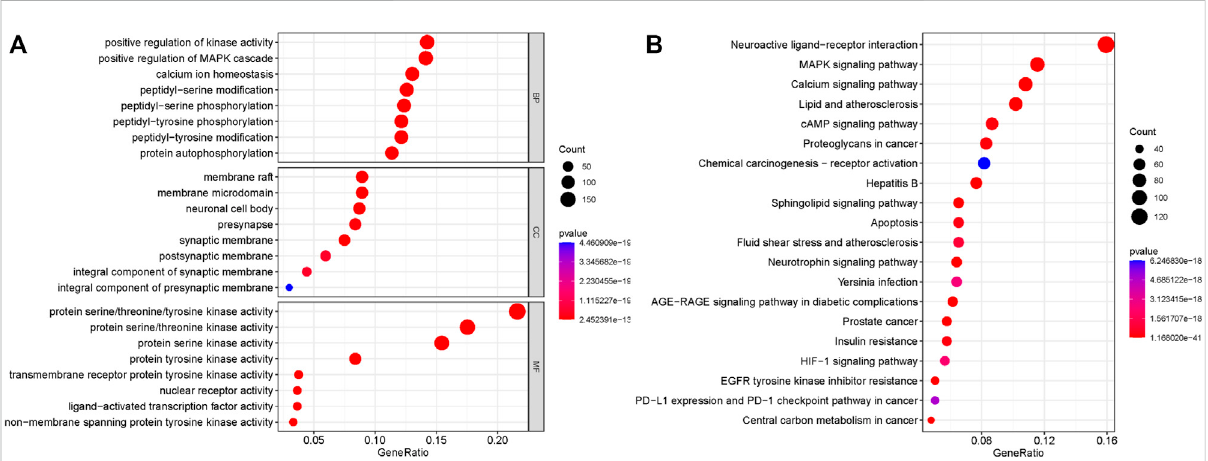
FIGURE 3 GOanalysis andKEGGpathway enrichmentanalysisofthe319sharedtargets. (A) GOanalysisofthesharedtargets.Theabscissarepresentsthe number of targets; the leftrepresents BP,CC, and MF; and thecolor represents the p -value. The smaller the p -value, the more red thecolor is, while thelargerthe p -value,themorebluethecoloris. (B) KEGGpathwayenrichmentanalysisofthesharedtargets.Theabscissarepresentsthenumberof genes enriched, the left represents the pathway name, and the color represents the p -value. The smaller the p -value, the more red the color, and the larger the p -value, the more blue the